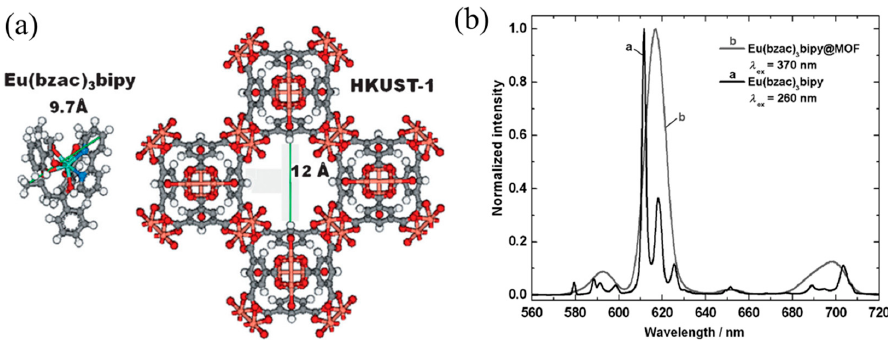
Figure 13. ( a ) Size of Eu(bzac) 3 bipy and pore size of HKUST-1; ( b ) Room-temperature emission spectra of powdered Eu(bzac) 3 bipy and powdered Cu 3 (btc) 2 -MOF loaded with Eu(bzac) 3 bipy. Reprinted